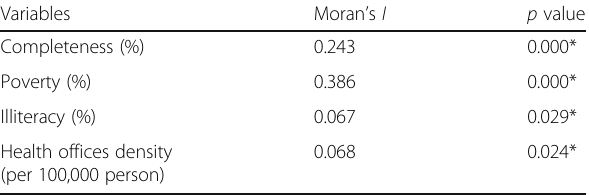
Table 3 Moran ’ s I test for spatial autocorrelation of all variables Variables Moran ’ s I p value